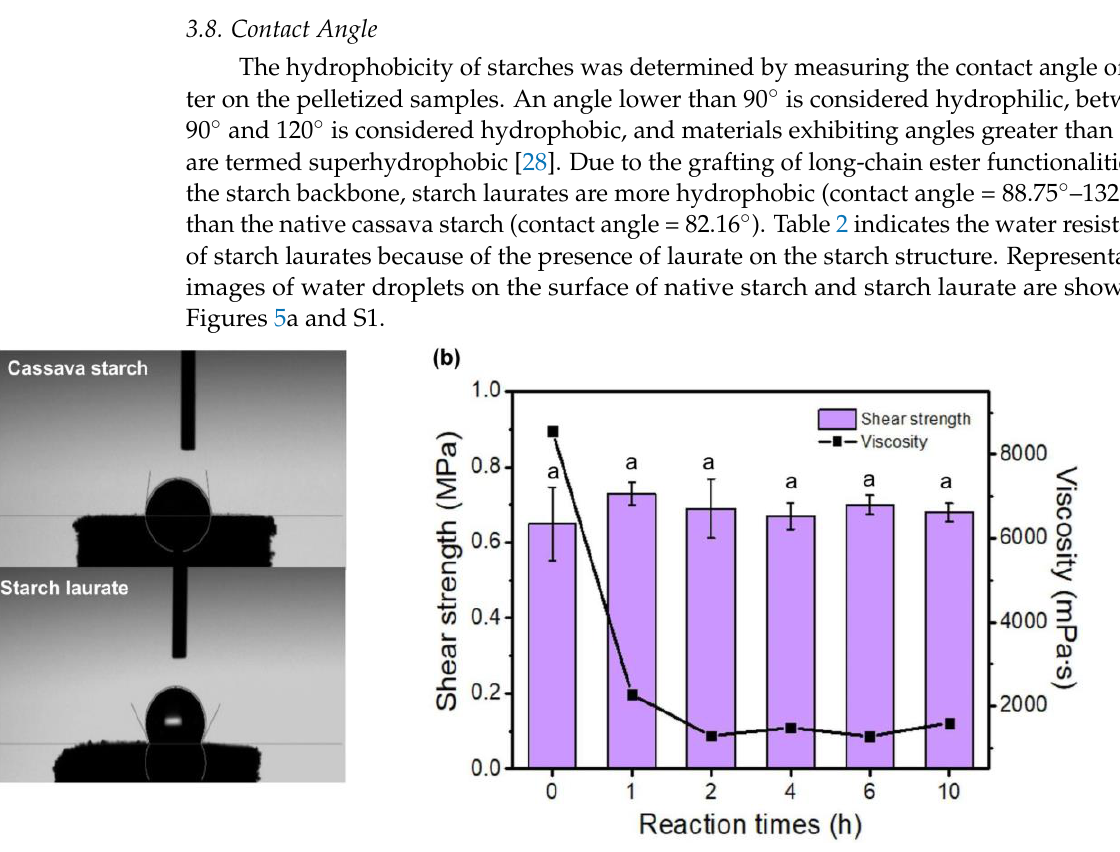
Figure 5. ( a ) Contact angle images of cassava starch and starch laurate (10 h) and ( b ) shear strength and viscosity of cassava starch adhesive and starch laurate adhesives. Group classification (a) was given to the data based on the statistical analysis results (significant difference; p ≤